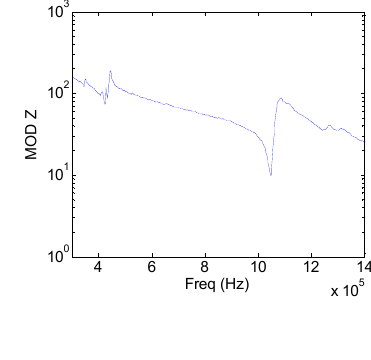
Figure 10. Experimental results for Model 3, ( a ) Module and phase of the electrical impedance; ( b ) Aluminum surface out-of plane mechanical displacement in linear arbitrary units; ( c ) Mechanical maximum displacement amplitude along the radius; ( d ) Relative mechanical displacement amplitude as a function of time along the radius in logarithmic scale.